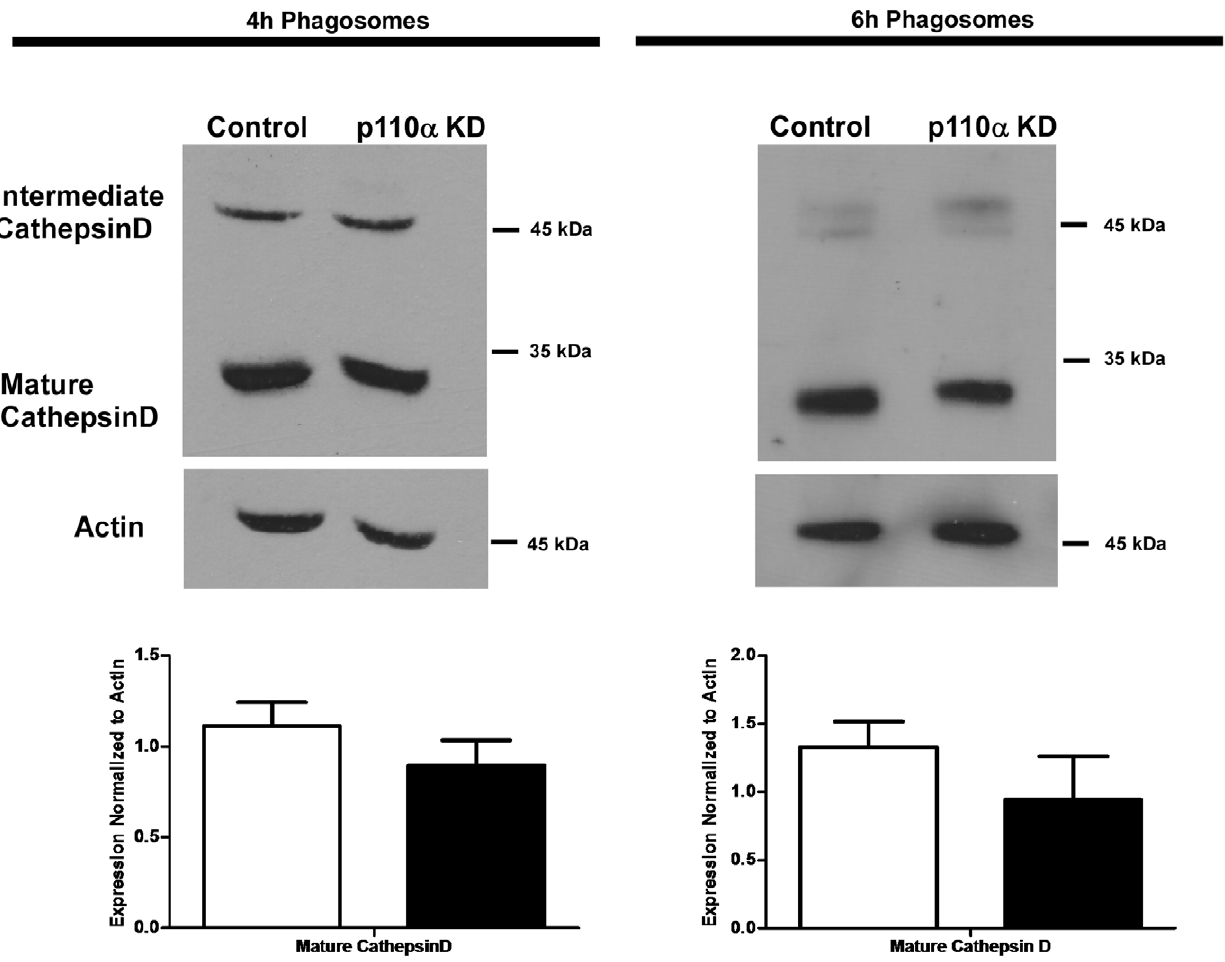
Figure 6. Phagosomes isolated from p110 a knockdown cells show normal recruitment and processing of the protease cathepsin D. Lysates from 4 and 6 hour phagosomes were prepared, separated by SDS-PAGE and transferred to nitrocellulose membrane. Blots were probed with an antibody for cathepsin D. Actin is shown as a loading control. Although a trend towards less cathepsin D in the phagosome lysates from p110 a knockdown cells was observed, it was not found to be statistically significant. Empty bars = control cells, solid bars = p110 a knockdown cells. Data are means + / 2 s.e.m., from four independent experiments.